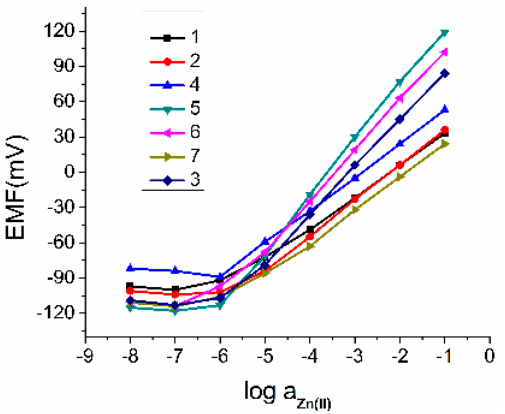
Figure 3. Response of N -(2-nitrophenyl)benzene-1,2-diamine (DPA) towards different membrane compositions given in Table 1.